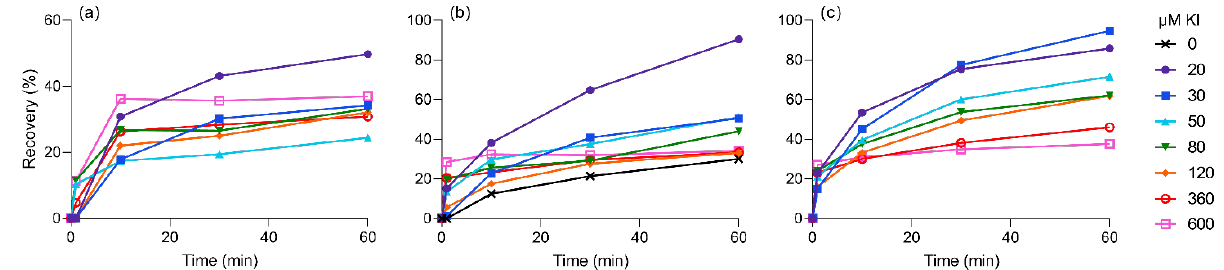
Figure 5. Recovery of monochloramine based on fluorescence measurements at different pH (pH 6.0 ( a ), pH 6.4 ( b ), and pH 7.4 ( c )) values with different amount of rotation iodide added (25 µM pyridoxamine and 17.6 µM (=1 mg Cl 2 /L) monochloramine, ratio 1:1, λ ex 330 nm, λ em 396 nm).